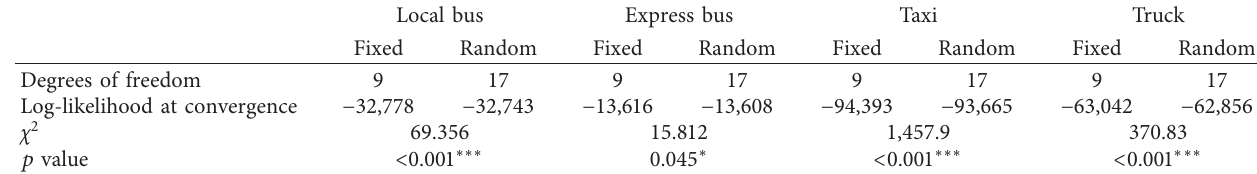
Table 5: Log-likelihood ratio test result for the fixed and random parameter logit models.